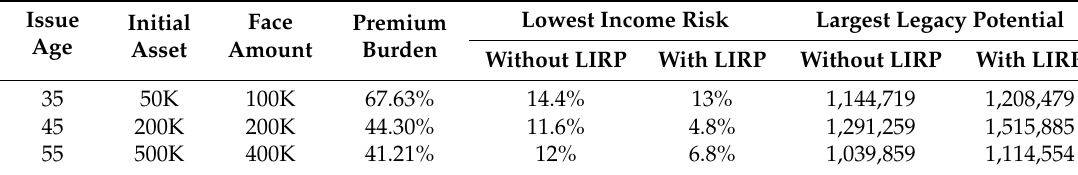
Table 7. Issue age